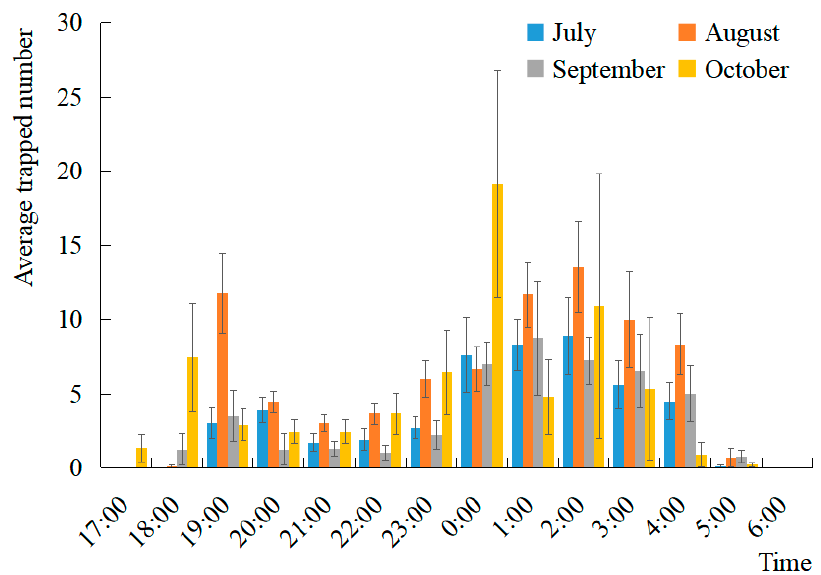
Figure 7. Diurnal rhythm of S. litura male moths trapped by AIM-lite-A from July to October in 2021. Time points 7:00–16:00 are not shown in the figure; S. litura were almost not trapped at these time points.